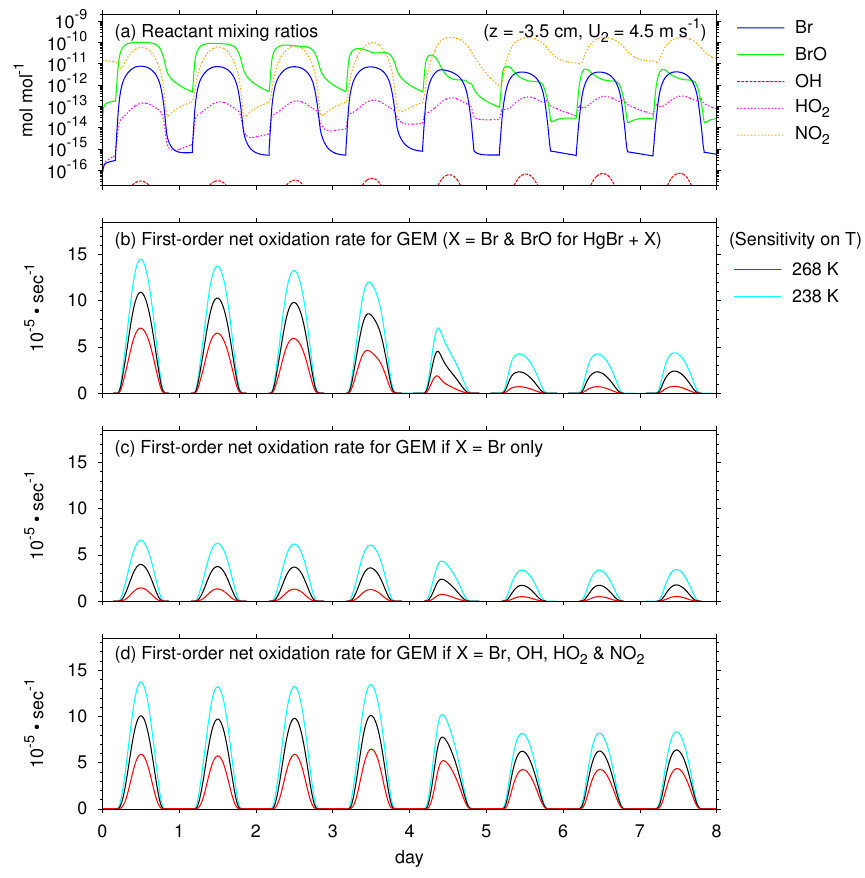
Fig. 9. The same as Fig. 8 but in the SIA at the depth of 3.5 cm.